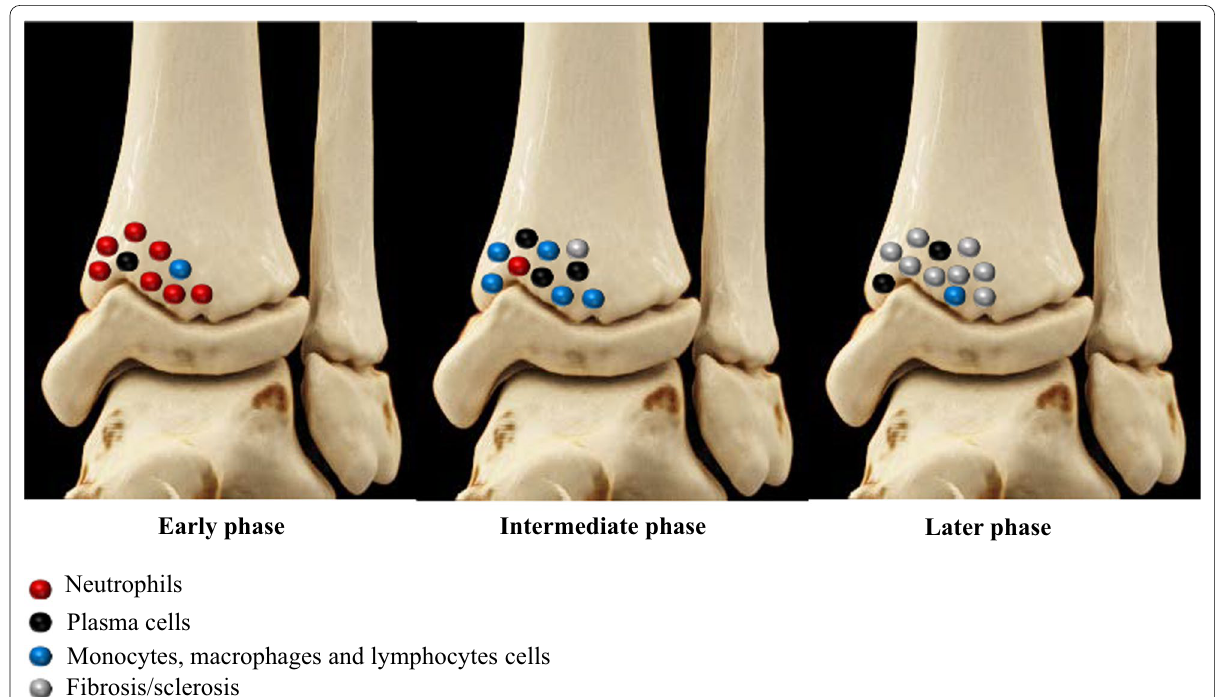
Fig. 1 Schematic distribution of inflammatory cells related to the stage of